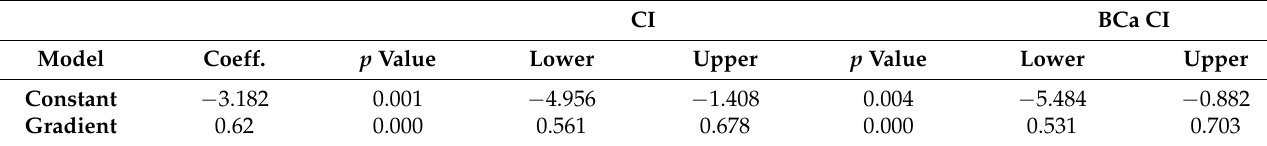
Table 1. Descriptive and Inferential Statistics of Equation (6) at α = 0.05. CI BCa